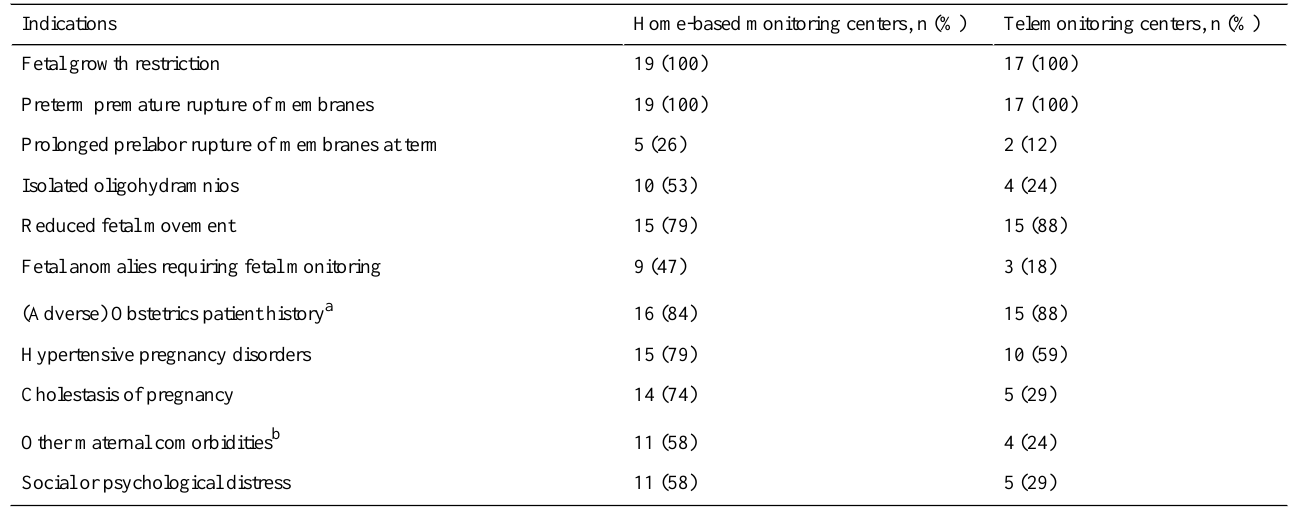
Table 2. Indications for home-based monitoring (n=19) and telemonitoring (n=17) in high-risk